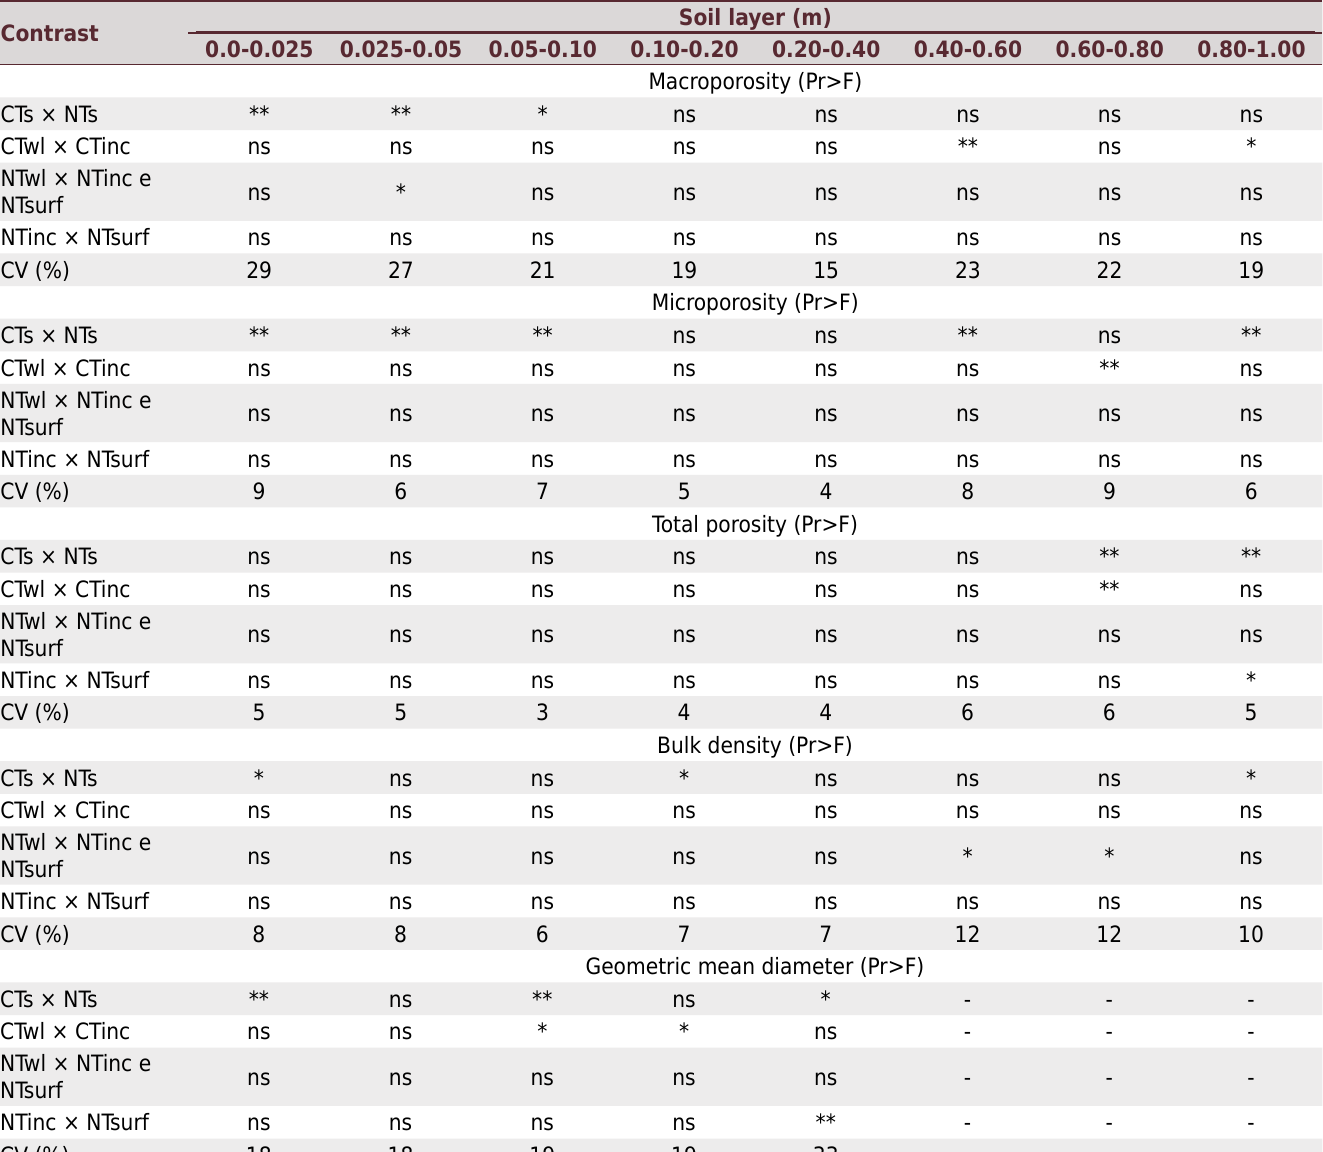
Table 1. Contrasts of combinations between tillage systems and liming methods for macroporosity, microporosity, total porosity, soil bulk density and geometric mean diameter of soil aggregates in a Latossolo Bruno Alumínico típico (Hapludox)